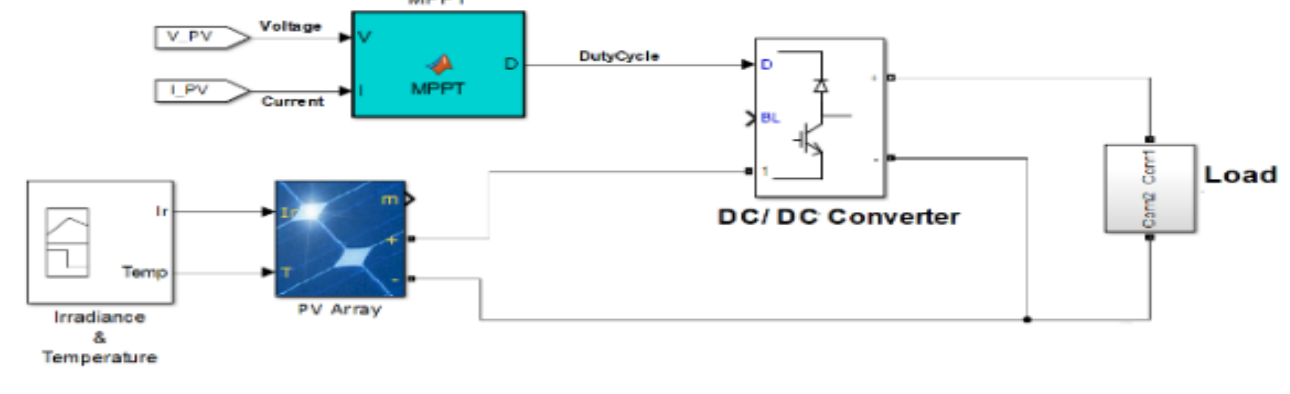
Fig. 4. Standalone solar photovoltaic system